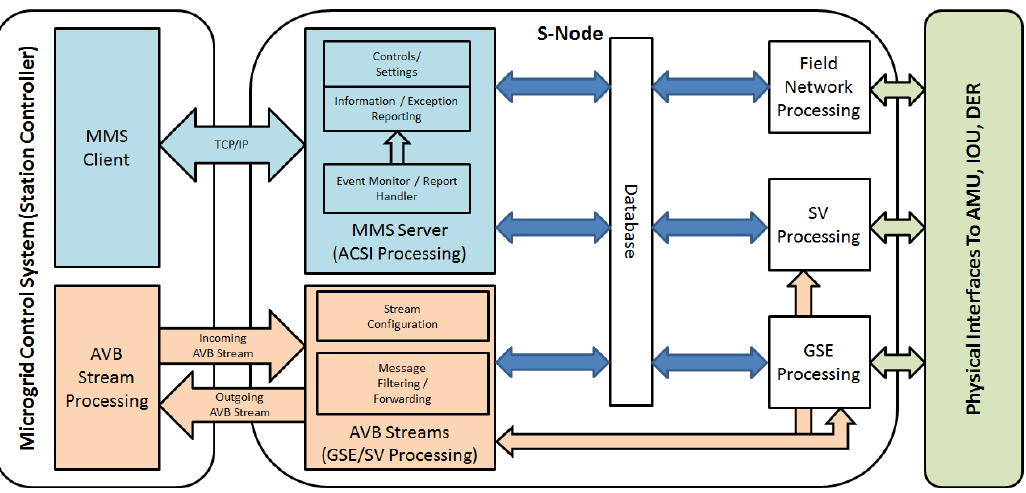
Figure 4. Audio video bridging (AVB) streaming in an IEC 61850 based microgrid communications